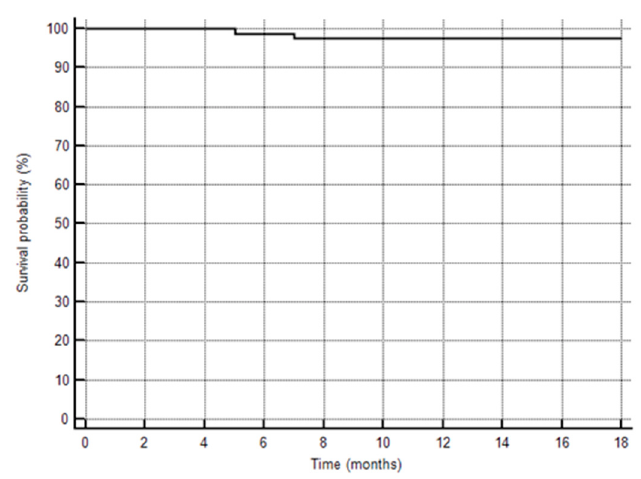
Figure 4. Kaplan–Meier curve to show survival of the study patients. 292